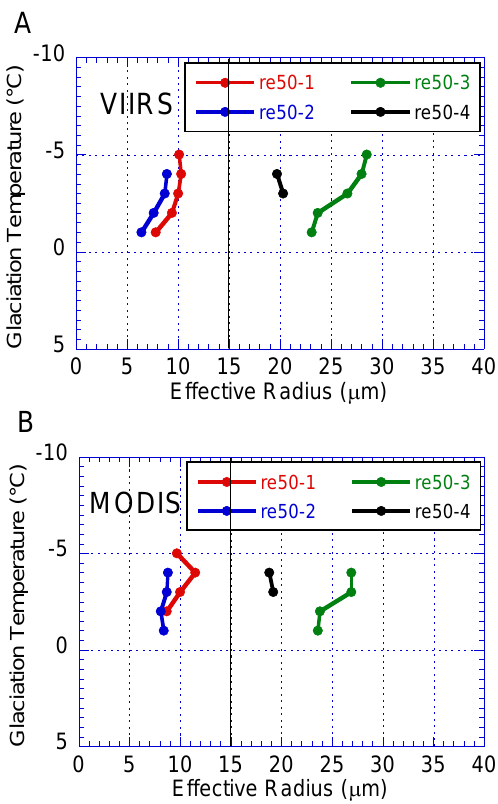
Fig. 5. The T – r e relations of the areas shown in Fig. 3 and denoted by white numbers, for VIIRS and MODIS. The median r e for any given T is shown. The r e values in the pollution tracks are much smaller than for the background clouds and are similar for both sen- sors. Note that VIIRS shows that T for the clouds with retrieved r e ranges between − 1 and − 5 ◦ C, whereas MODIS misses some of the warmest and coldest cloudy points because they are averaged out by the lower resolution.